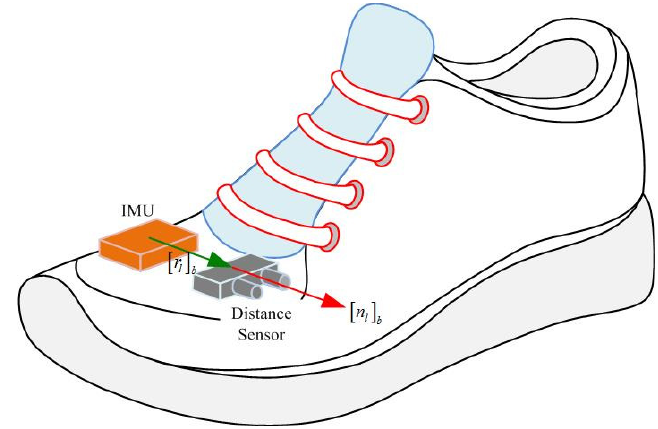
Figure 1. IMU and distance sensor on a